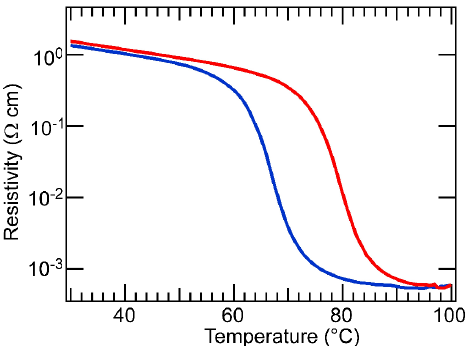
Figure 1. Temperature dependent resistivity curve for epitaxial VO 2 film grown on Al 2 O 3 (0001). Drastic changes in resistivity corresponding to the insulator-metal transition (IMT) and metal-insulator transition (MIT) occurs at ~77 °C and ~65 °C in the heating (red line) and cooling (blue line) processes, respectively.